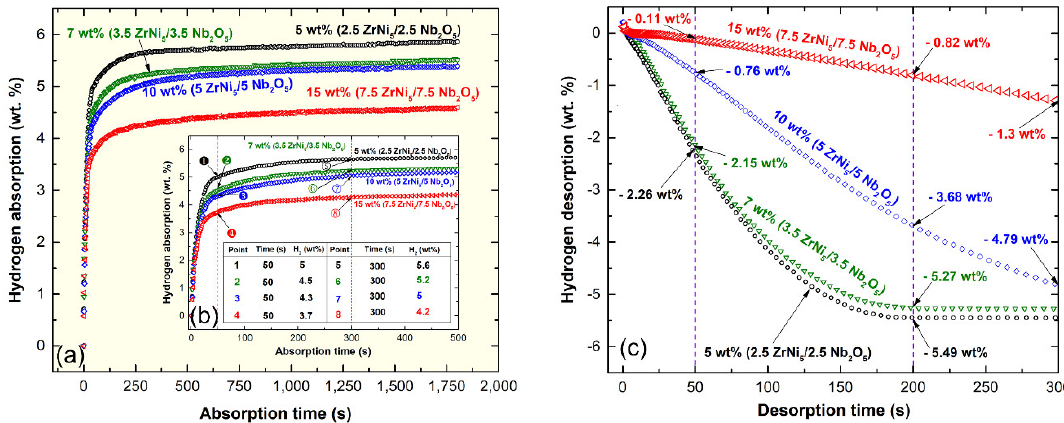
Figure 8. Kinetics of ( a , b ) hydrogenation and ( c ) dehydrogenation for nanocomposite MgH 2 doped with low, medium, and high concentrations of binary ZrNi 5 /Nb 2 O 5 catalysts after milling for 50 h.